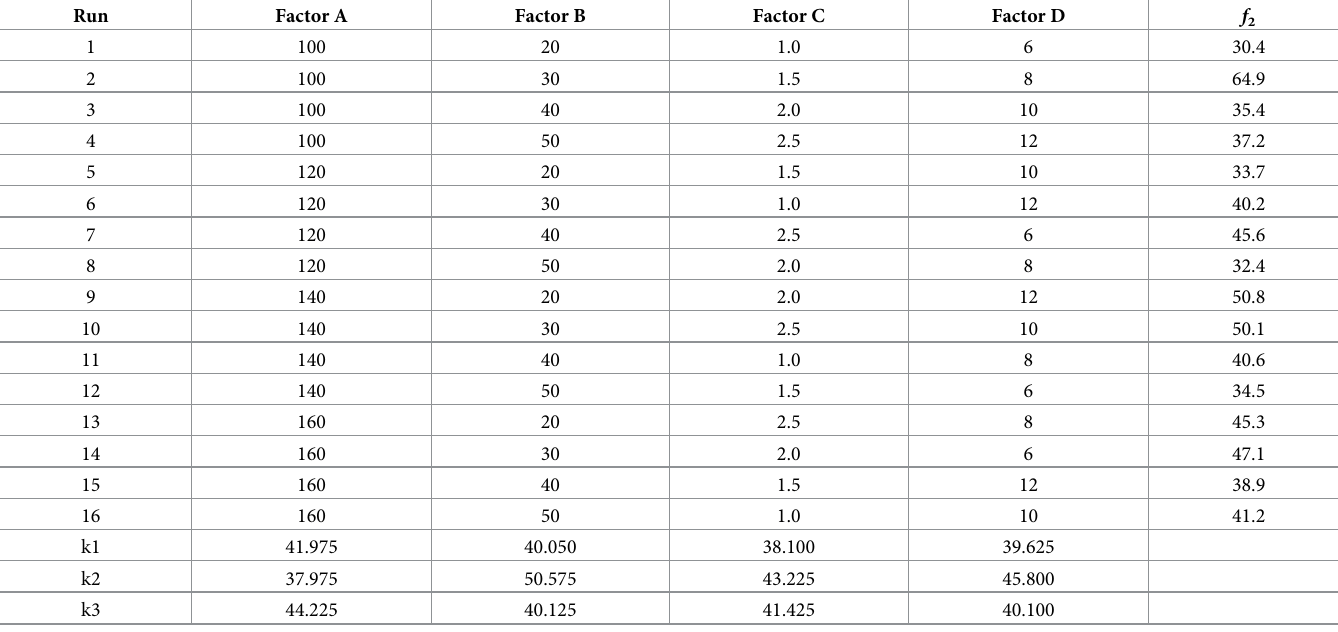
Fig 12. Effect of orifice size on TPM release (n = 6). https://doi.org/10.1371/journal.pone.0264457.g012 Table 3. Experimental plan and results of orthogonal design (L 16 (4 5